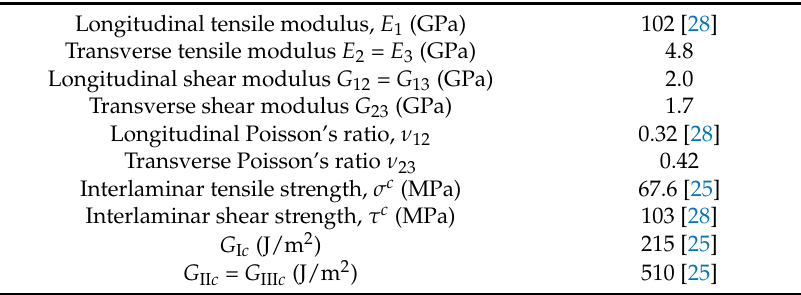
Table 1. Laminar mechanical properties.